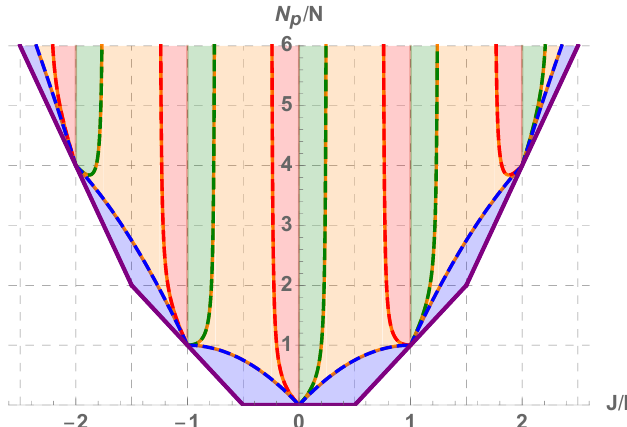
Figure 8 . The phase diagram on the J - N p plane, now taking into account of the spectral (cid:13)owed